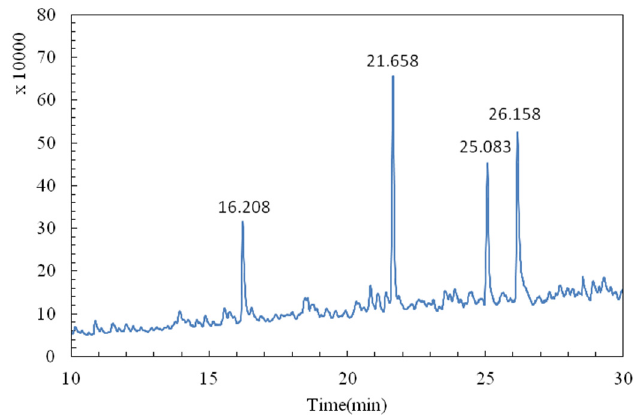
Figure 3. GC-MS chromatogram for methylation analysis of AAP-b2.